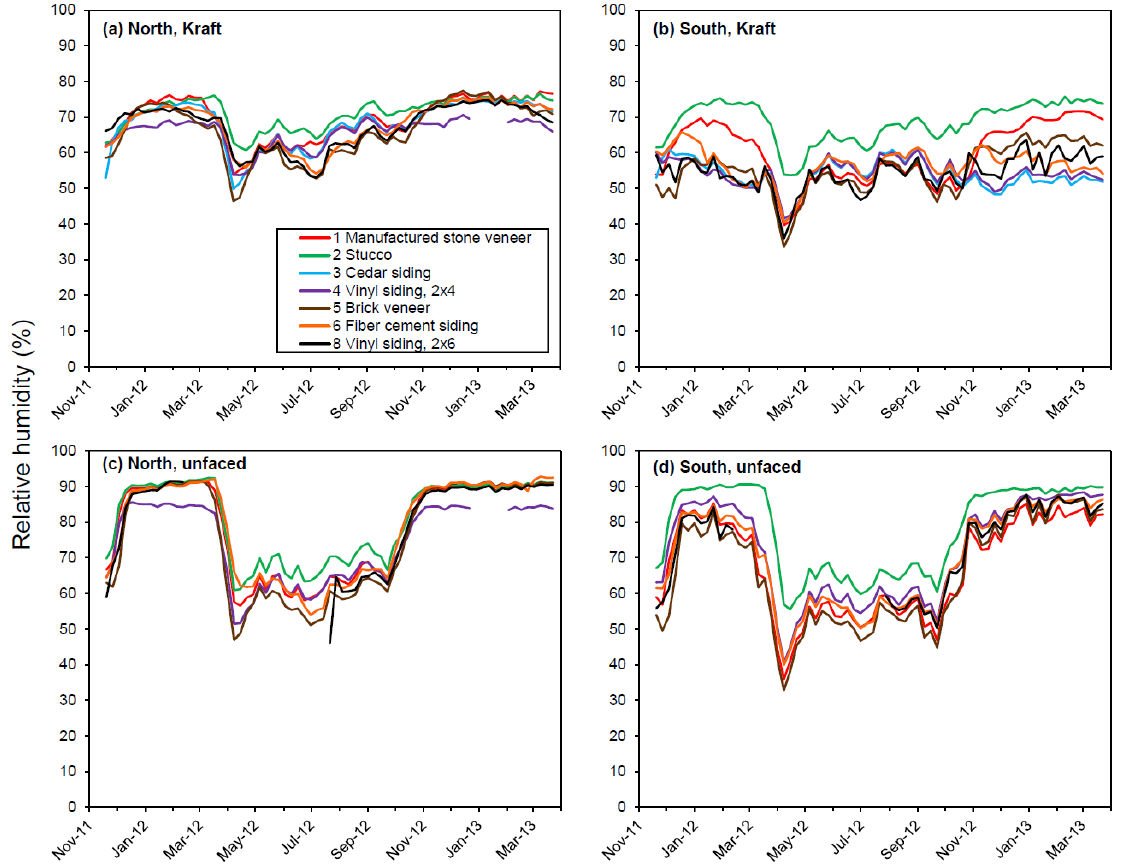
Figure 7. Relative humidity levels measured in cavities of ( a ) North-facing walls with kraft-faced batts; ( b ) South-facing walls with kraft-faced batts; ( c ) North-facing walls with unfaced batts; and ( d ) South-facing walls with unfaced batts.